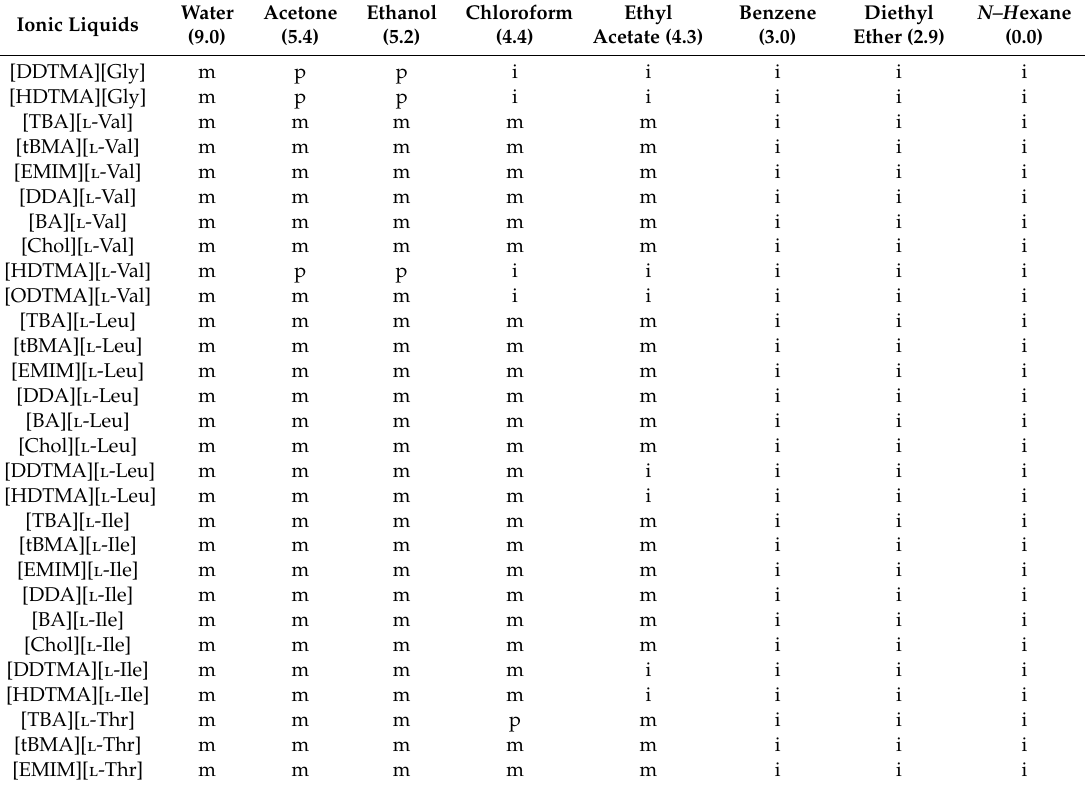
Table 4. Miscibility with other solvents of amino acid ionic liquids [TBA][AA].